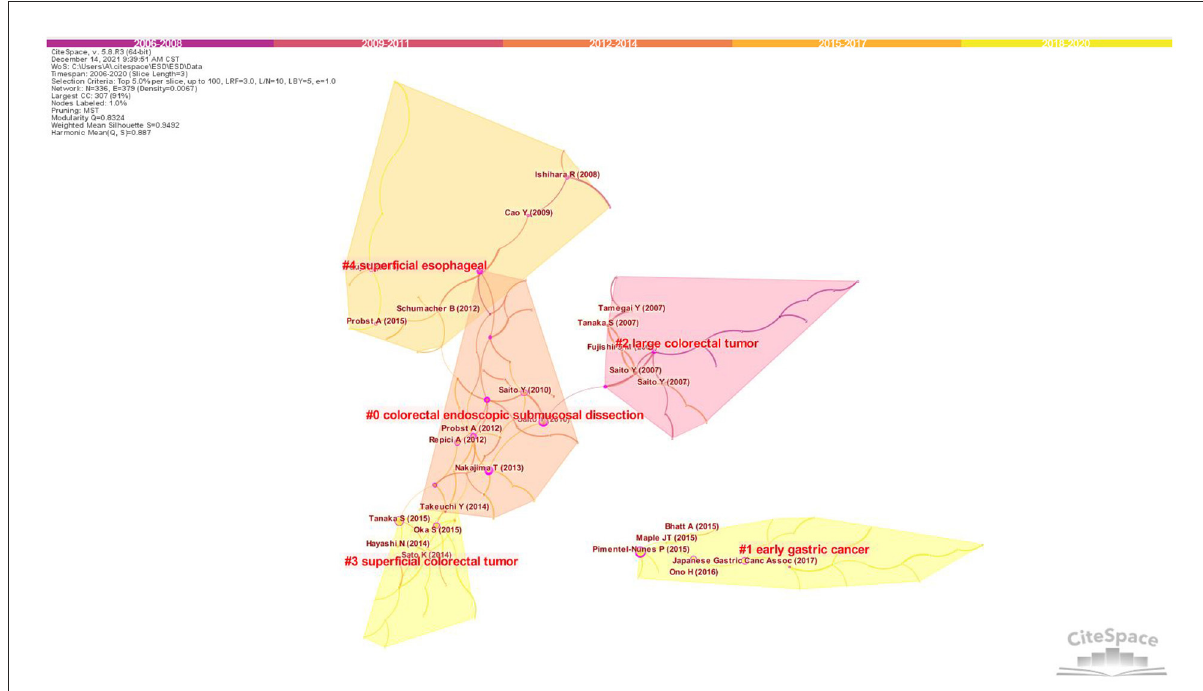
FIGURE5 Clustering map of reference co-citation related to research of ESD, 2006-2020. The larger the circle, the more frequently it is co-citated. The wider the purple circle, the stronger the centrality.